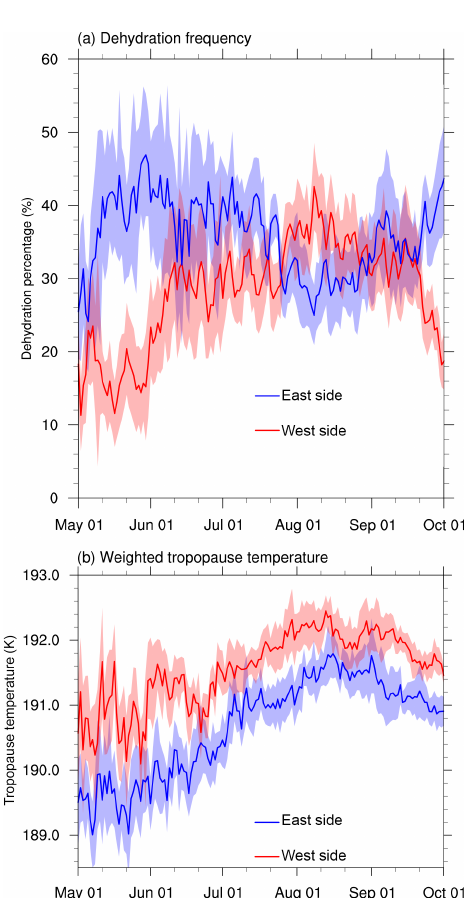
Figure 3. (a) Climatological time series of percentage of dehy- dration (%) located over the west side (15–35 ◦ N, 50–80 ◦ E, red line) and the east side (10–30 ◦ N, 90–120 ◦ E, blue line) for air parcels located at 100hPa over the Asian monsoon region based on traj_ERAi. (b) Average tropopause temperatures weighted by the dehydration frequency distributions over the west side and the east side respectively based on traj_ERAi. The color shadings indicate the corresponding standard deviation intervals.